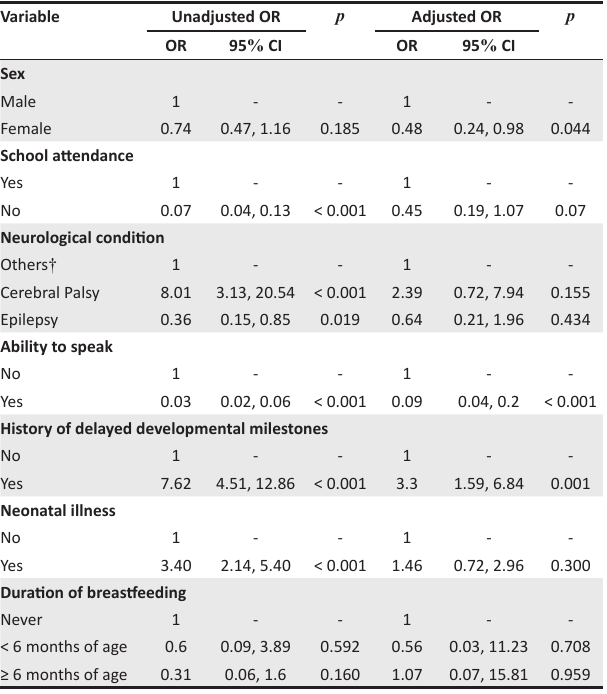
TABLE 4: Logistic regression estimates of factors associated with screening positive for autism spectrum disorder. Variable Unadjusted OR p Adjusted